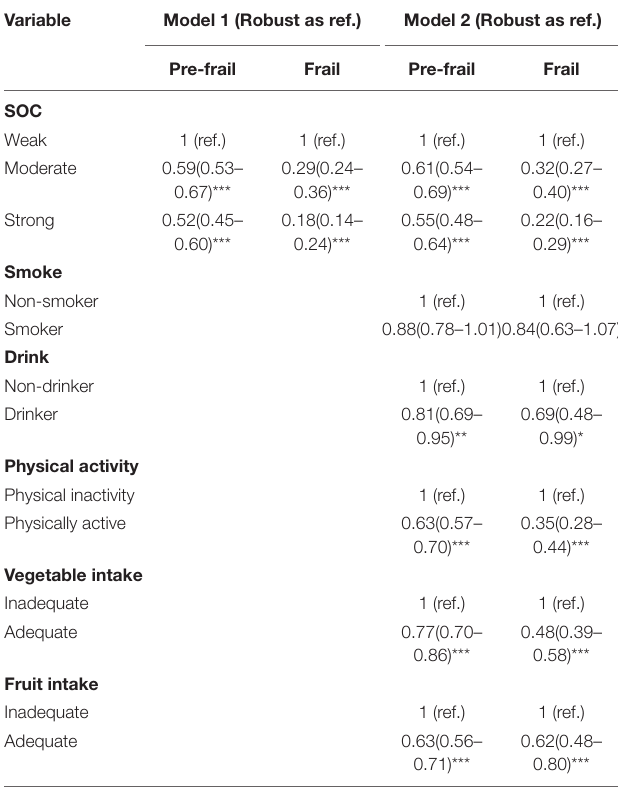
TABLE 2 | The associations between SOC and frailty by using multinomial logistic regressions. Variable Model 1 (Robust as ref.) Model 2 (Robust as